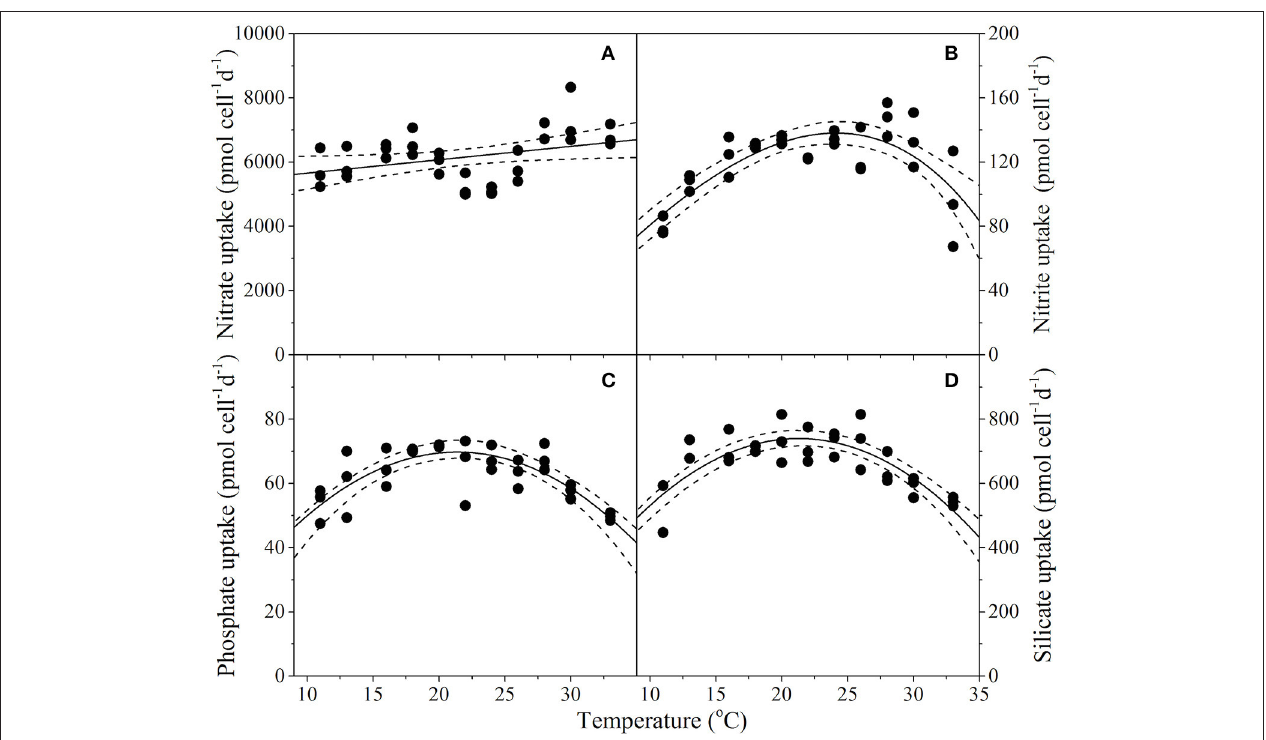
FIGURE 6 | Thermal performance curves of physiological traits in the diatom Thalassiosira pseudonana depicting uptake of dissolved nutrients (A) nitrate ( n = 33, p = 0.039, R 2 = 0.10); (B) nitrite ( n = 33, RSME = 13.7); (C) phosphate ( n = 33, RSME = 5.2); and (D) silicate ( n = 33, RSME = 54.4), as a function of temperature. Each symbol represents a distinct biological replicate. Solid lines corresponds to maximum likelihood estimate with broken lines corresponding to the 95% confidence intervals of (A) linear regression, and (B–D) the bell-shape function (Equation 1), all estimated by parametric